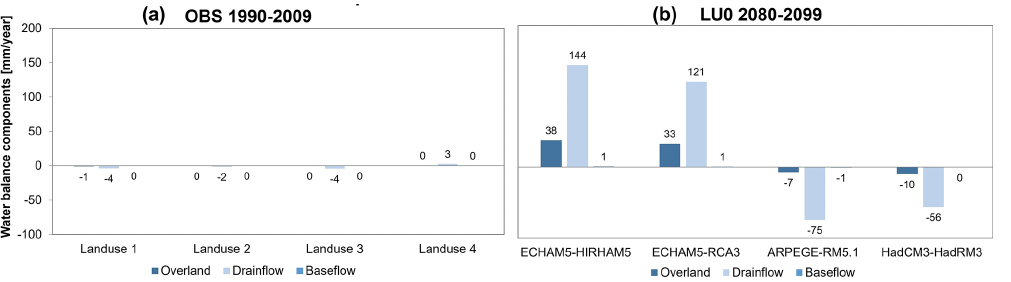
Figure 4. The change in the distribution of the water balance components in millimetres per year (mmyr − 1 ) caused by changes in land use and climate change. (a) The difference for the four land use scenarios LU1–4 (scenarios 2–5) and the baseline scenario with LU0 (scenario 1). (b) The difference between the four future climate model scenarios (scenarios 26, 31, 36, and 41) and the corresponding climate model reference period (scenarios 6, 11, 16, and 21), all for LU0 (modified from Karlsson et al., 2016).